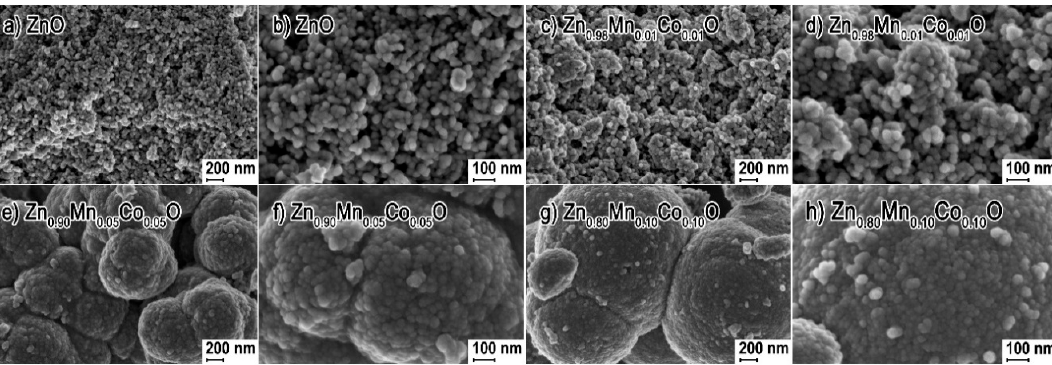
Figure 2. SEM images of NPs: ( a , b ) ZnO; ( c , d ) Zn 0.98 Co 0.01 Mn 0.01 O; ( e , f ) Zn 0.90 Co 0.05 Mn 0.05 O; ( g , f ) Zn 0.8 Co 0.1 Mn 0.1 O.